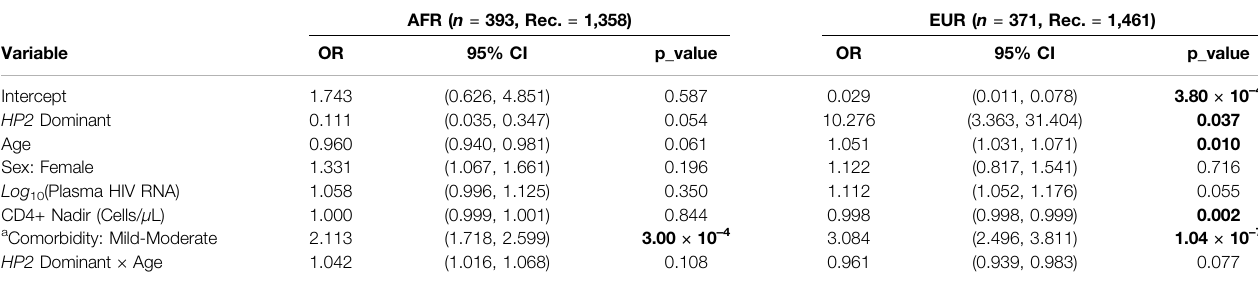
TABLE 3 | HP2 dominant effect on NCI in the AFR and EUR participants over time.